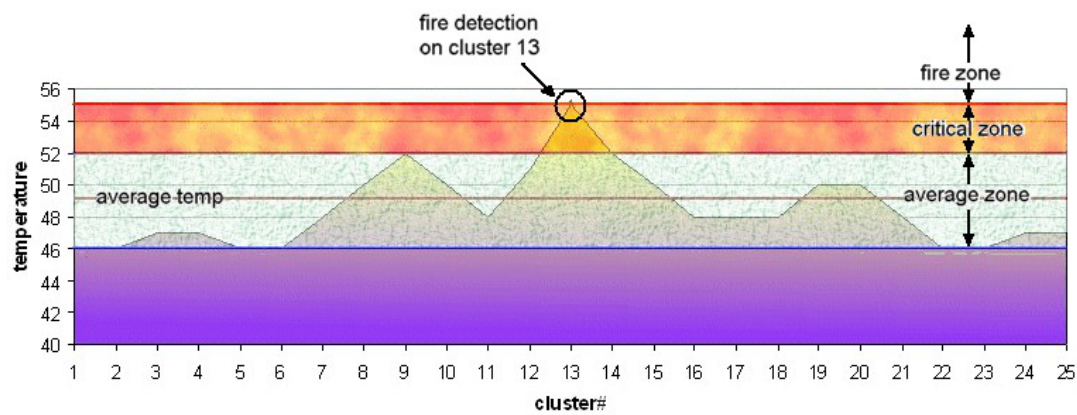
Figure 5. Warm region thermal data